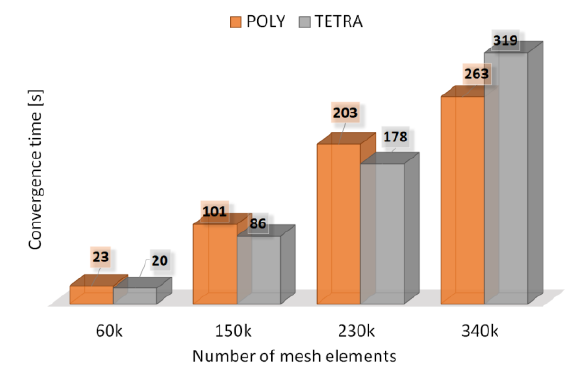
Fig. 7. Time to convergence of the analysed